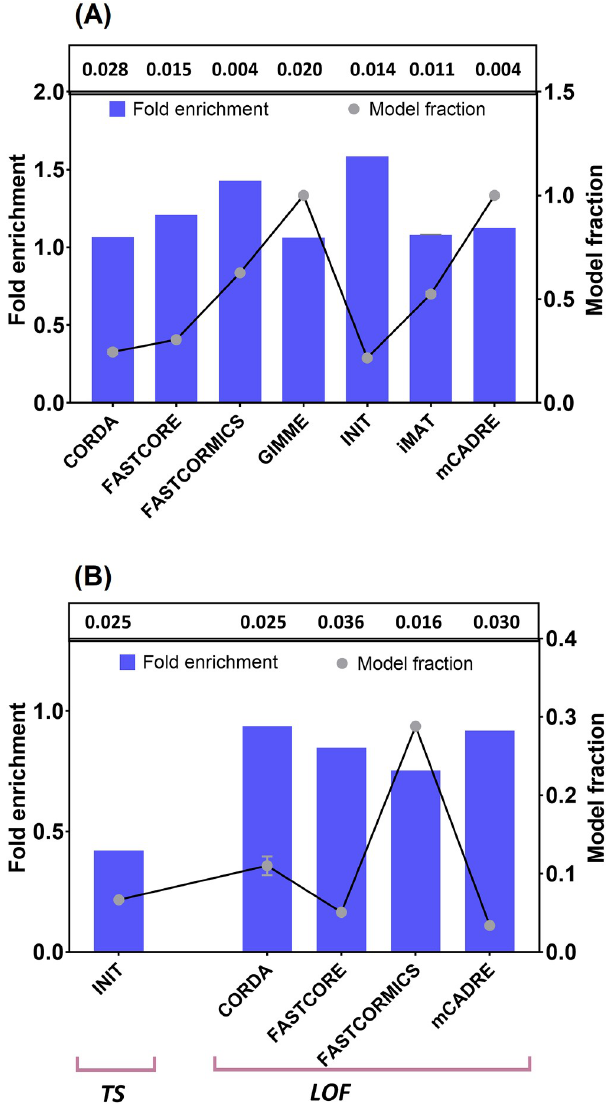
Fig 5. Prediction of oncogenes (OG), tumor suppressors (TS) and loss of function (LOF) mutations. Mean enrichment of predicted (A) OGs and (B) TS and LOFs with experimental data. The error bars show the standard deviation across GEMs generated with general and cell-specific media. Hypergeometric p-values are shown above each figure. Model fraction represents the fraction of generated GEMs with significant p-values ( < 0.05). Only methods with significant predictions are